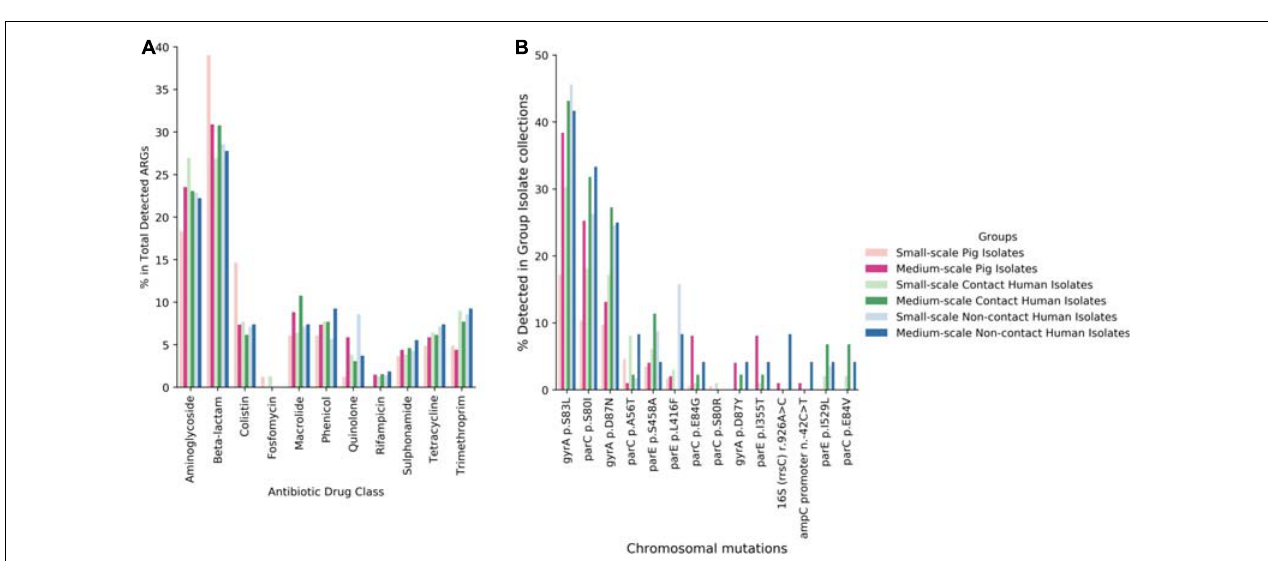
FIGURE 3 | Venn diagrams displaying number of antibiotic resistance genes (ARGs) shared between different investigation groups. (A) Comparison of total antibiotic resistance genes in small-scale farms. (B) Comparison of total antibiotic resistance genes in medium-scale farms.